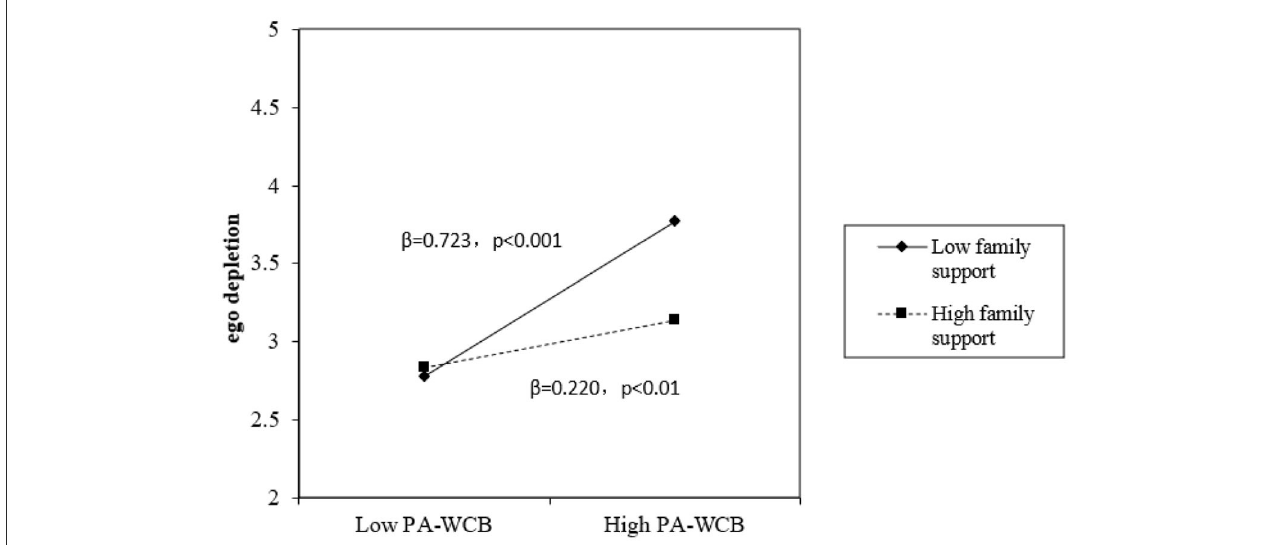
FIGURE3 The moderating effect of family support on the impact of PA-WCB on ego depletion.